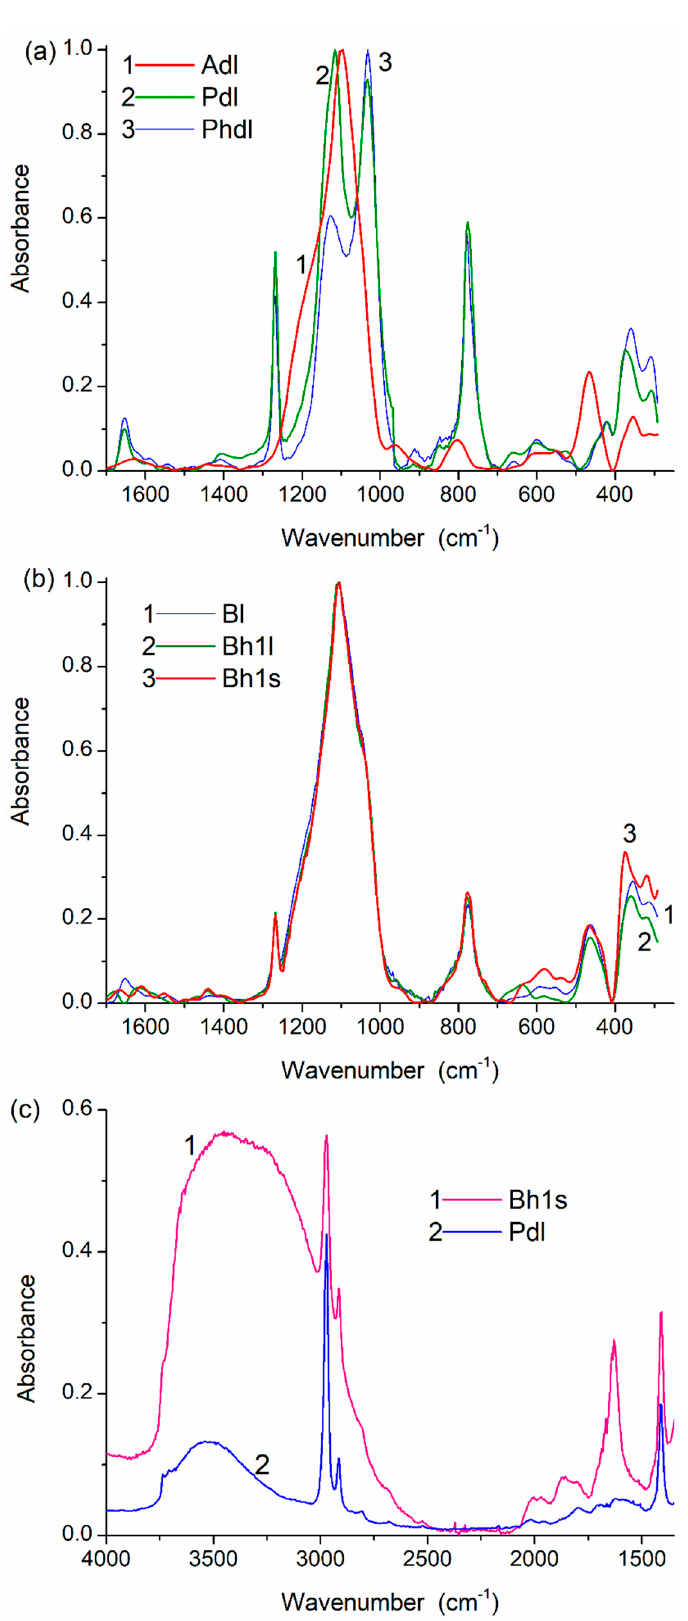
Figure 5. IR spectra of ( a , c ) PMS, A-300 and ( b , c ) their blends in the range of ( a , b ) 1700–300 cm − 1 and ( c ) 4000–1300 cm − 1 .